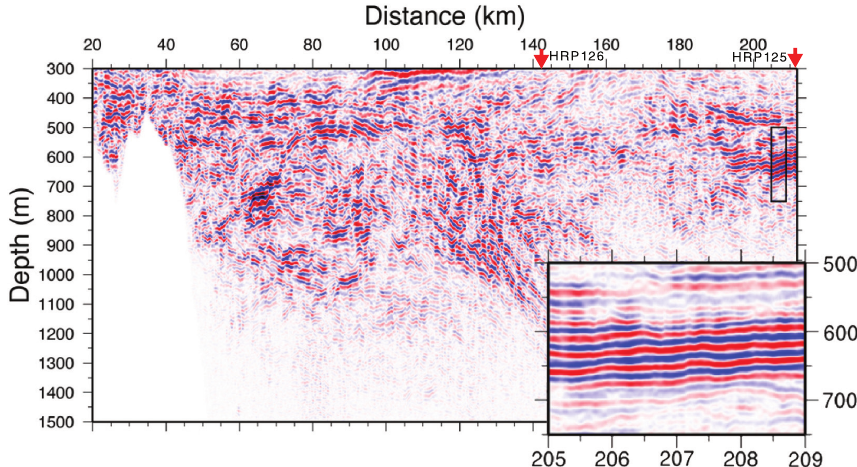
Fig. 2. Vertically exaggerated seismic image of Line D2, collected from west to east across the Caribbean Sea with the shelf of Guadeloupe on the left (masked white). The thermohaline staircase is the high amplitude reflective package (inset) visible from about 190–212km at depths between 550 and 700m. These regular, uniformly spaced, banded layers are unique to this part of the section. Relative positions of the HRP dives 125 and 126, collected 3 years after the seismic survey, and approximately 5.8 and 1.6km north of the seismic line respectively, are marked on top.